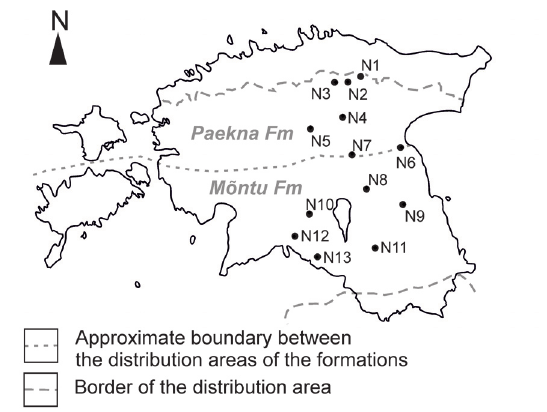
Fig. 5. Distribution of the lower Nabala RS and the location of